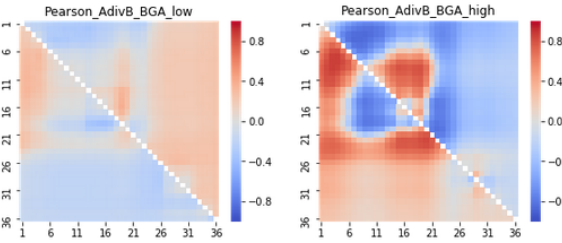
Figure 11. A/B-correlations for the parameter BGA by the parameter classes